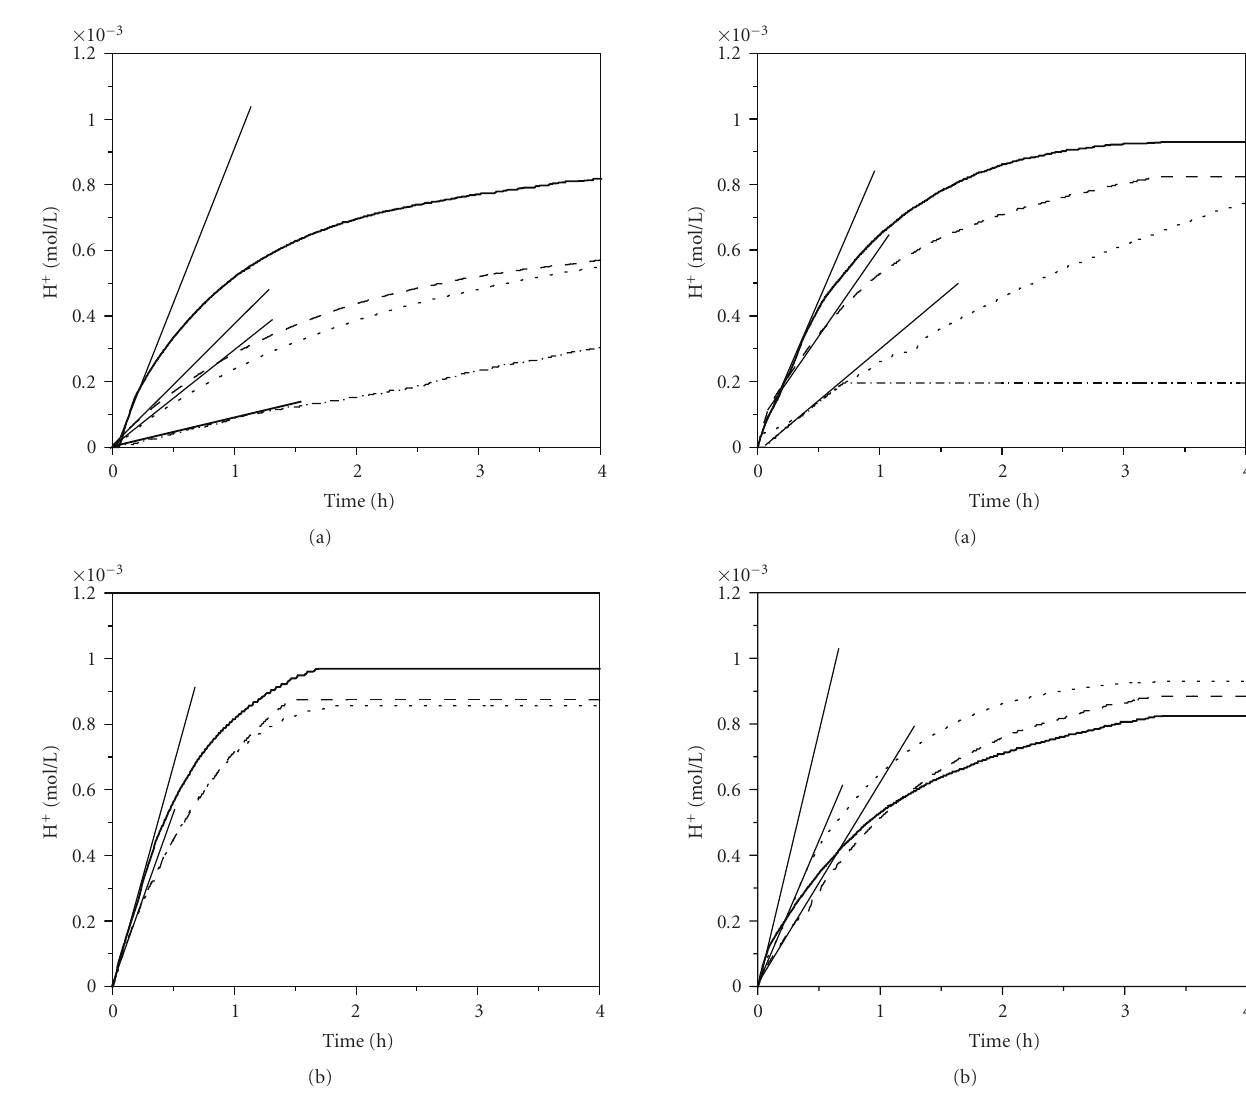
Figure 3: (a) Degradation of DCA (shown as release of H + ) using the photocatalyst 0.35 Ag-TiO 2 at pH 3 in 3 consecutive runs, 1st run (—), 2nd run (–––), 3rd run ( ··· ), a 3rd run (- · -) with addition of 4mM Cl − before the run started, and slope ( ) used for the determination of the photonic e ffi ciency of each run with I ≈ 3 . 39 × 10 − 2 Einstein L − 1 h − 1 . The photocatalyst loading was 0.5 g/L. (b) Degradation of DCA (shown as release of H + ) using the photocatalyst 0.35 Ag-TiO 2 at pH 3 in 3 consecutive runs with intermittent washing between runs, 1st run (—), 2nd run (–––), 3rd run ( ··· ), and slope ( ) used for the determination of the photonic e ffi ciency with I ≈ 3 . 39 × 10 − 2 Einstein L − 1 h − 1 . The photocatalyst loading was 0.5